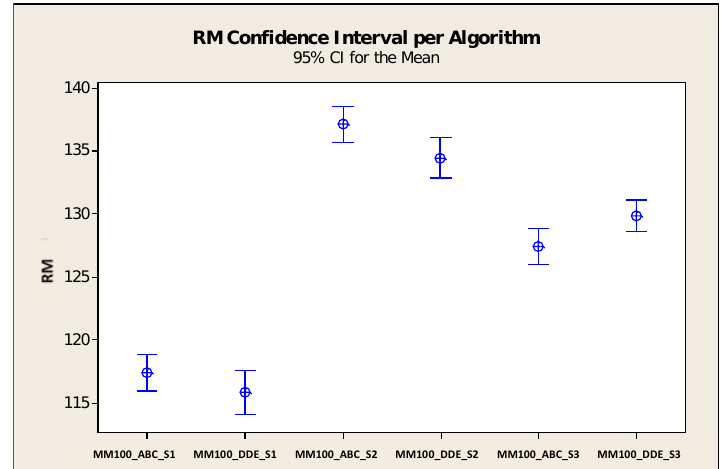
Figure 8. Robustness measure CI for each algorithm and stage for MM100 instances.